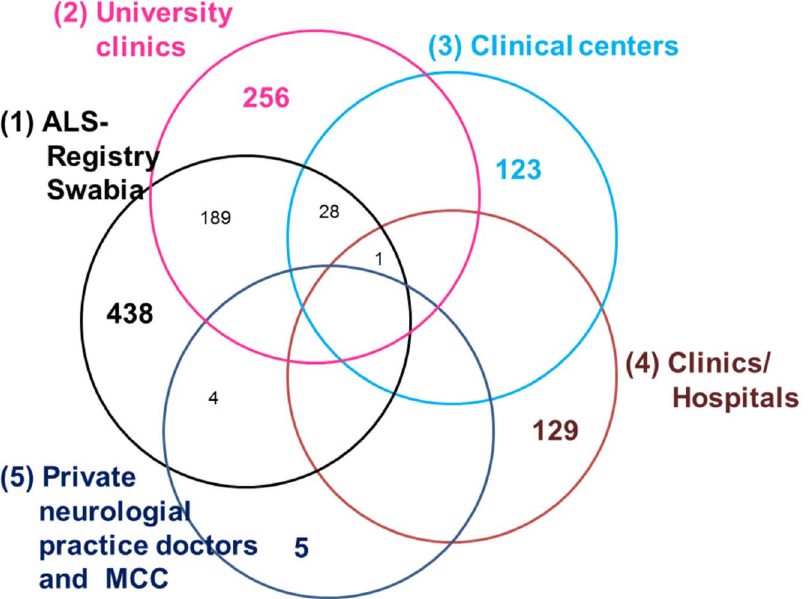
Figure 3. Data source intersections of the ALS cases in Southern Germany. Abbreviation: MCC Medical Care Centers. Other Intersections: (1),(3),(4)=2; (1),(3)=91; (1),(4)=95; (1),(2),(4)=31;